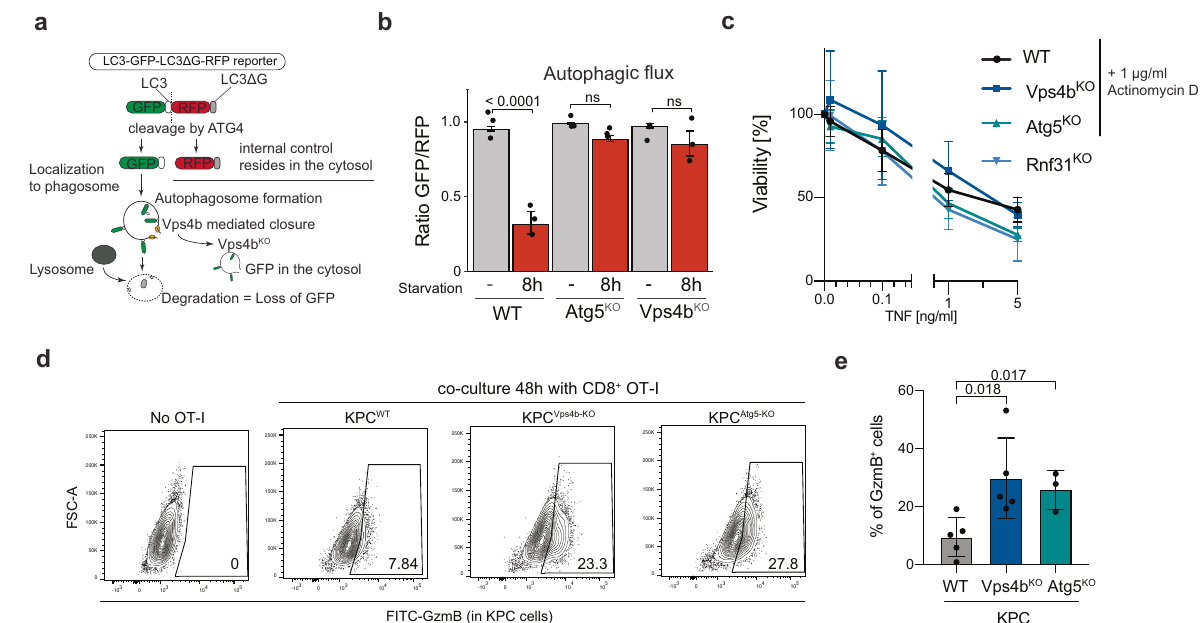
Fig. 5 Disruption of Vps4b leads to impaired autophagy and granzyme B accumulation in tumor cells. a Schematic of autophagic fl ux reporter based on the LC3-GFP-LC3 Δ G-RFP probe adapted from Kaizuka et al. 31 . b Quanti fi cation of autophagic fl ux by fl ow cytometry in different KPC lines under normal and starvation conditions (8h in PBS + 2% FBS). Bars represent the ratio of GFP to RFP expressing cells with n = 3 independent experiments. c Assessment of TNF sensitivity threshold in different KPC cells in the presence of 1 µ g/ml actinomycin D, except for Rnf31 KO ; here no Actinomycin D was present. Crystal violet staining was used for the quanti fi cation of viable cells. Represented data are relative to untreated control cells. Data are from n = 4 independent experiments. d Flow cytometric analysis of intracellular granzyme B in KPC-1 cells. Cells were gated on FSC/SCC — viability — CD8- negative. e Quanti fi cation of granzyme B positive cancer cells and T cells based on ( d ) n = 5 for WT and Vps4b and n = 3 for Atg5. Signi fi cance in ( b ) was determined with one-way ANOVA. Signi fi cance in ( e ) was determined with an unpaired, two-tailed t -test. ns, non-signi fi cant, p > 0.05. Values represent mean ± SD, data are derived from at least three independent experiments. Source data are provided as a Source Data fi